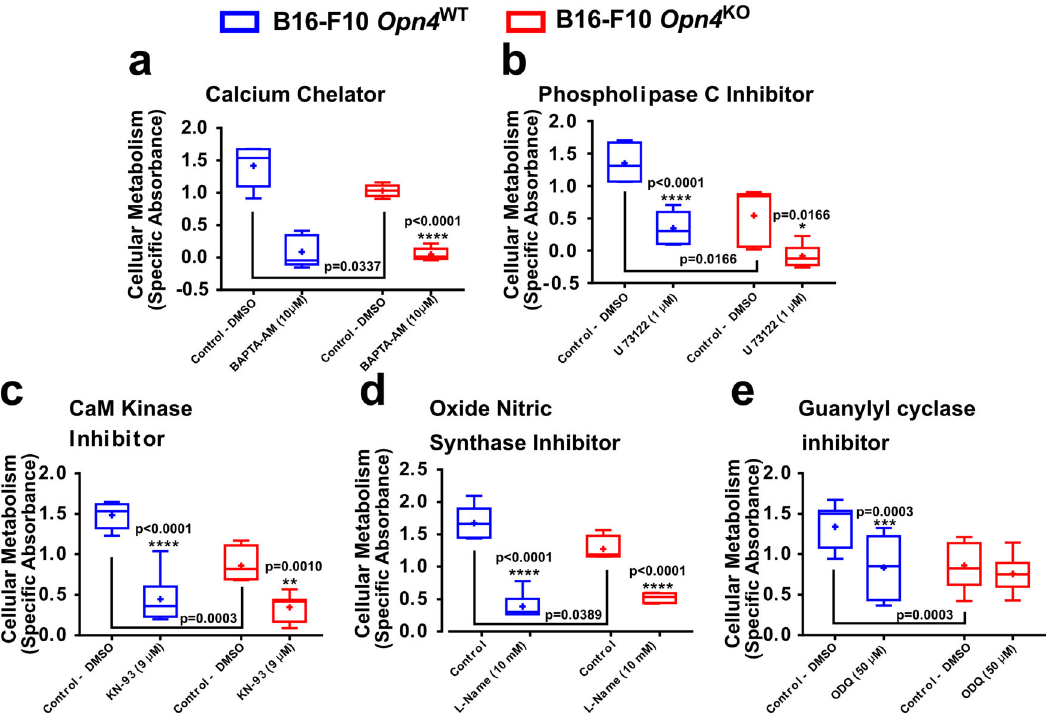
Fig. 4 Evaluation of the OPN4 classical signaling cascade in Opn4 WT and Opn4 KO malignant melanocytes in vitro. a – e Respective drugs ’ actions are shown in bold letters. Controls received either PBS or DMSO, depending on the drug vehicle. The highest DMSO concentration was 2%. * p < 0.05; ** p < 0.01; *** p < 0.001; **** p < 0.0001. Asterisks represent differences between control and treated groups within the same genotype. Brackets represent differences between Opn4 WT and Opn4 KO malignant melanocytes ( p values are shown). In a , n = 6 and 9, for Opn4 WT and Opn4 KO cells, respectively; In b , n = 6 and 5, respectively; in c , n = 5 and 7, respectively; in d , n = 5 and 4, respectively; in e , n = 10 and 12, respectively. In every analyzes, the n number is derived from independent